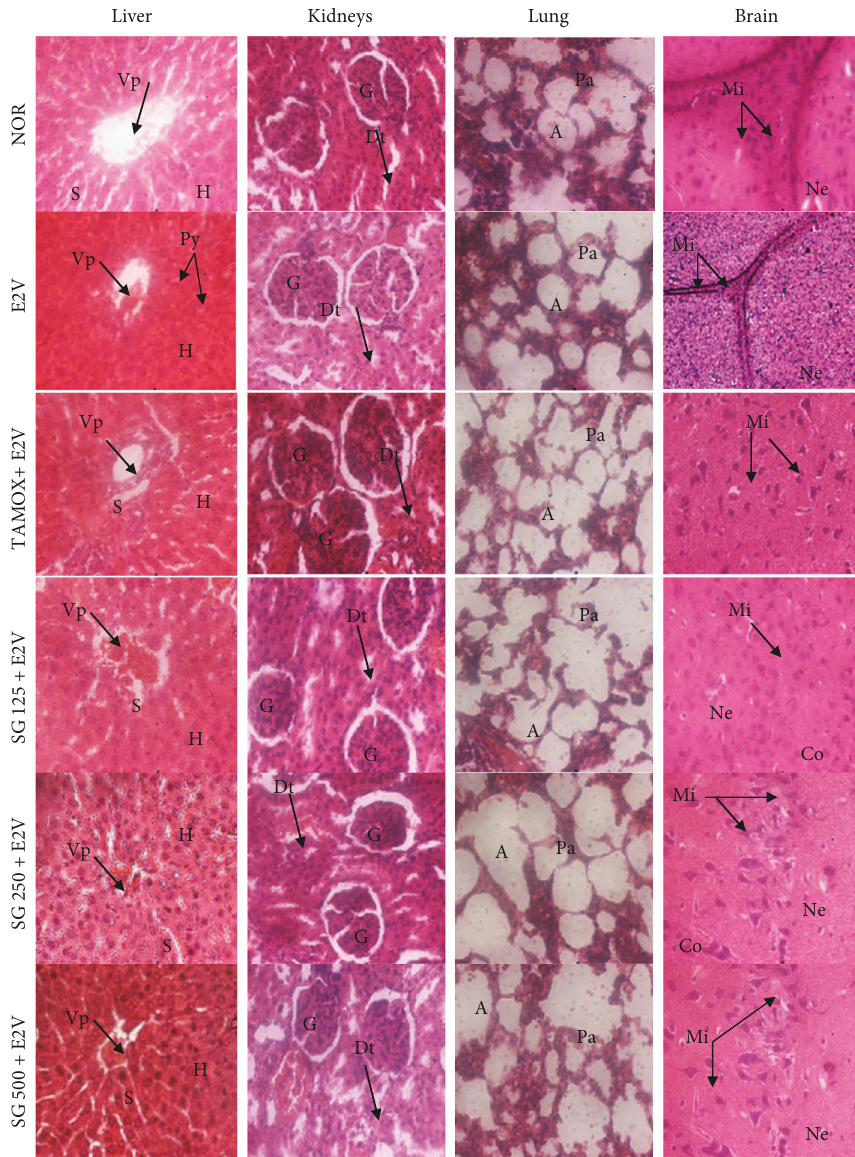
Figure 4: Effects of S. gilo hydroethanolic extract on microphotographs H and E 400 × of liver, kidney, lung, and brain after 16 weeks of treatment. NOR � Normal control treated with distilled water; E2V � E2V-control treated with distilled water; SG +E2V � Animals treated with the S. gilo hydroethanolic extract at the doses of 125, 250, and 500mg/kg BW. TAMOX+E2V � Animals treated with tamoxifen (3.3mg/kg BW); all groups except the normal group (NOR) received chronic administration of E2V at the dose of 1mg/kg BW. Data are represented as mean ± SEM (n � 6). Vp � Veine portal; H � Hepatocyte; S � Sinusoids; Py � Pyknotic nuclei; A � Alveoli; Ab � Aveolar bag; G � Glomerula; Dt � Distal tube; Pt � Proximal tube; Mi � Microglie; Ne � Neurone; Co �